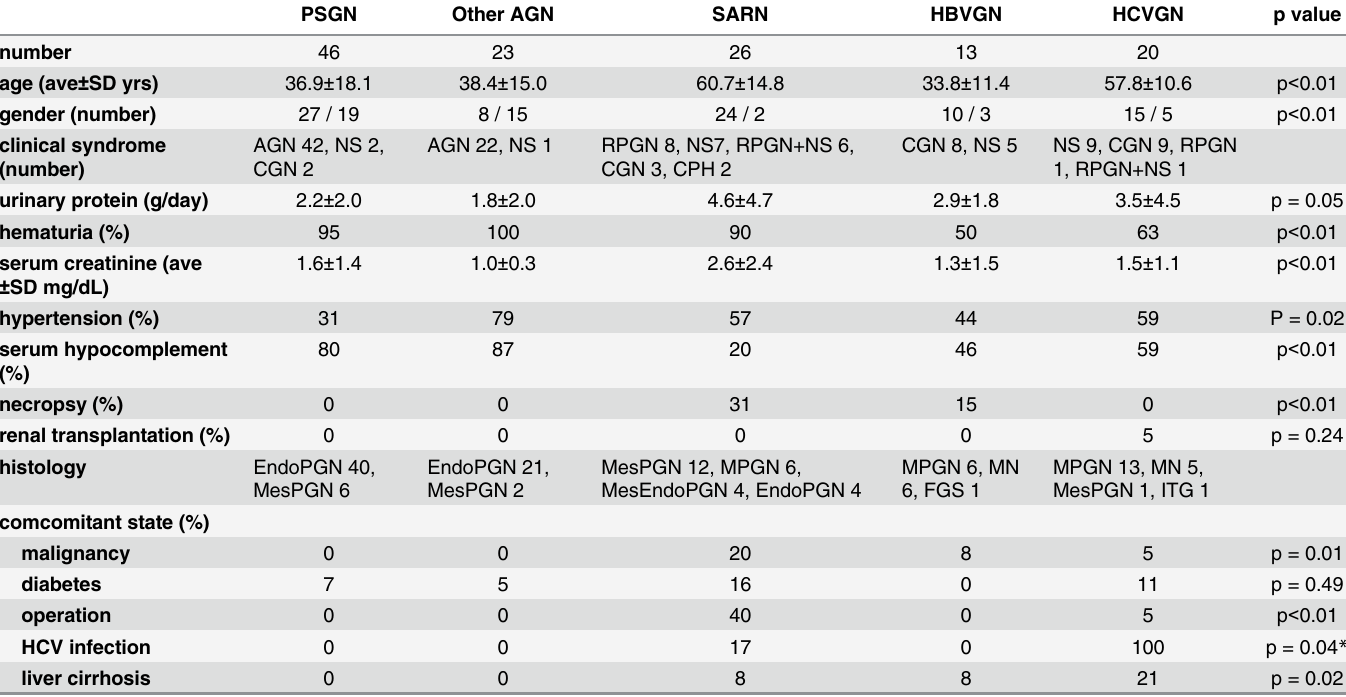
Table 1. Clinicopathological findings of each type of PIGN. PSGN Other AGN SARN HBVGN